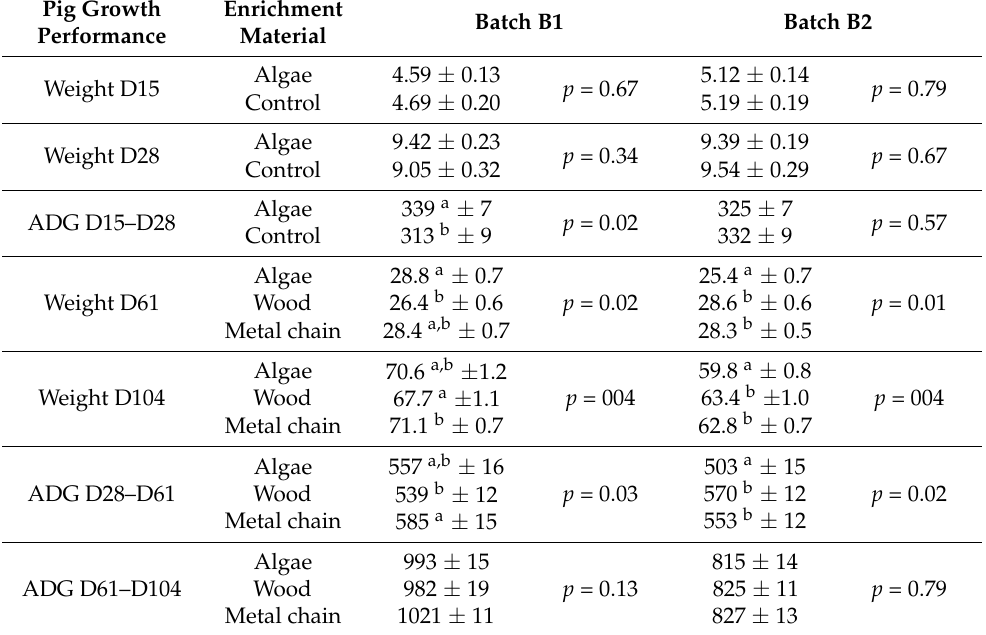
Table 4. Weight (kg) and average daily gain (ADG, g/day) (least square mean ± standard error) according to type of enrichment material in batch 1 (B1; n = 228 pigs) and batch 2 (B2; n = 215 pigs) during the suckling period, from Day 15 (D15) to D28, during the post-weaning period, from D28 to D61, and during the fattening period, from D61 to D104. Comparison was made with a mixed ANOVA model with the pen as random effect. As a batch effect was detected, batches were analyzed